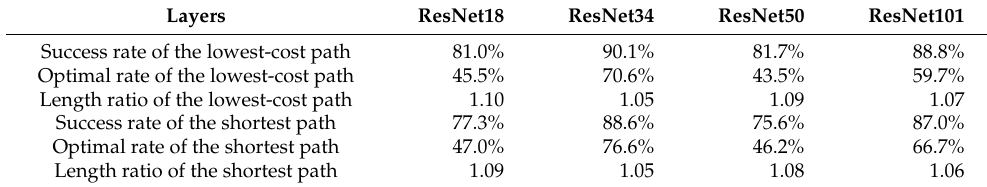
Table 3. Performance of the residual networks.